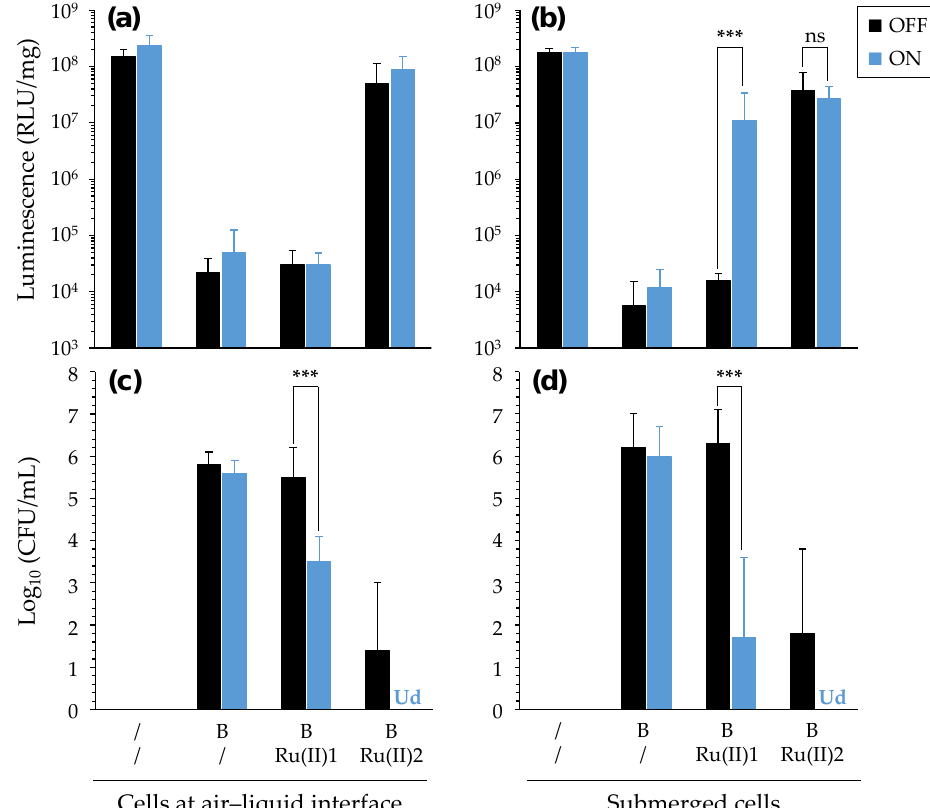
Figure 10. PDT effects of [Ru(II)] in the presence of eukaryotic cells cultured in different conditions. Results were obtained when assaying bacteria (B) with CFBE-Luc cells, with the latter being cul- tivated either at the air–liquid interface ( a , c ) or under submerged conditions ( b , d ). Luminescence measurements (( a , b ); expressed in the unit of RLU/mg of total protein) and CFU enumeration ( c , d ) were used to assess cell viability and antibacterial effects, respectively. Mean ± SD with n = 3 and N = 2. ***, p -value ≤ 0.001; “ns”: non-significant. “Ud”: